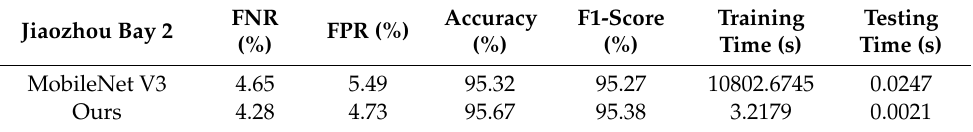
Table 4. Sand wave detection performance on Jiaozhou Bay 1&2.